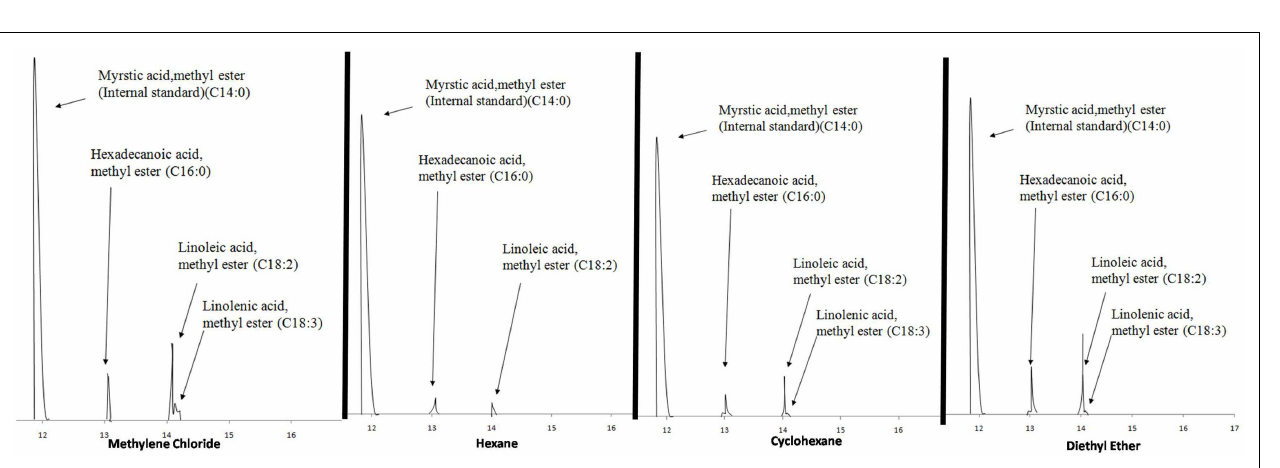
FIGURE 2 | Chromatogram of extracts from methylene chloride, hexane, cyclohexane, and diethyl ether